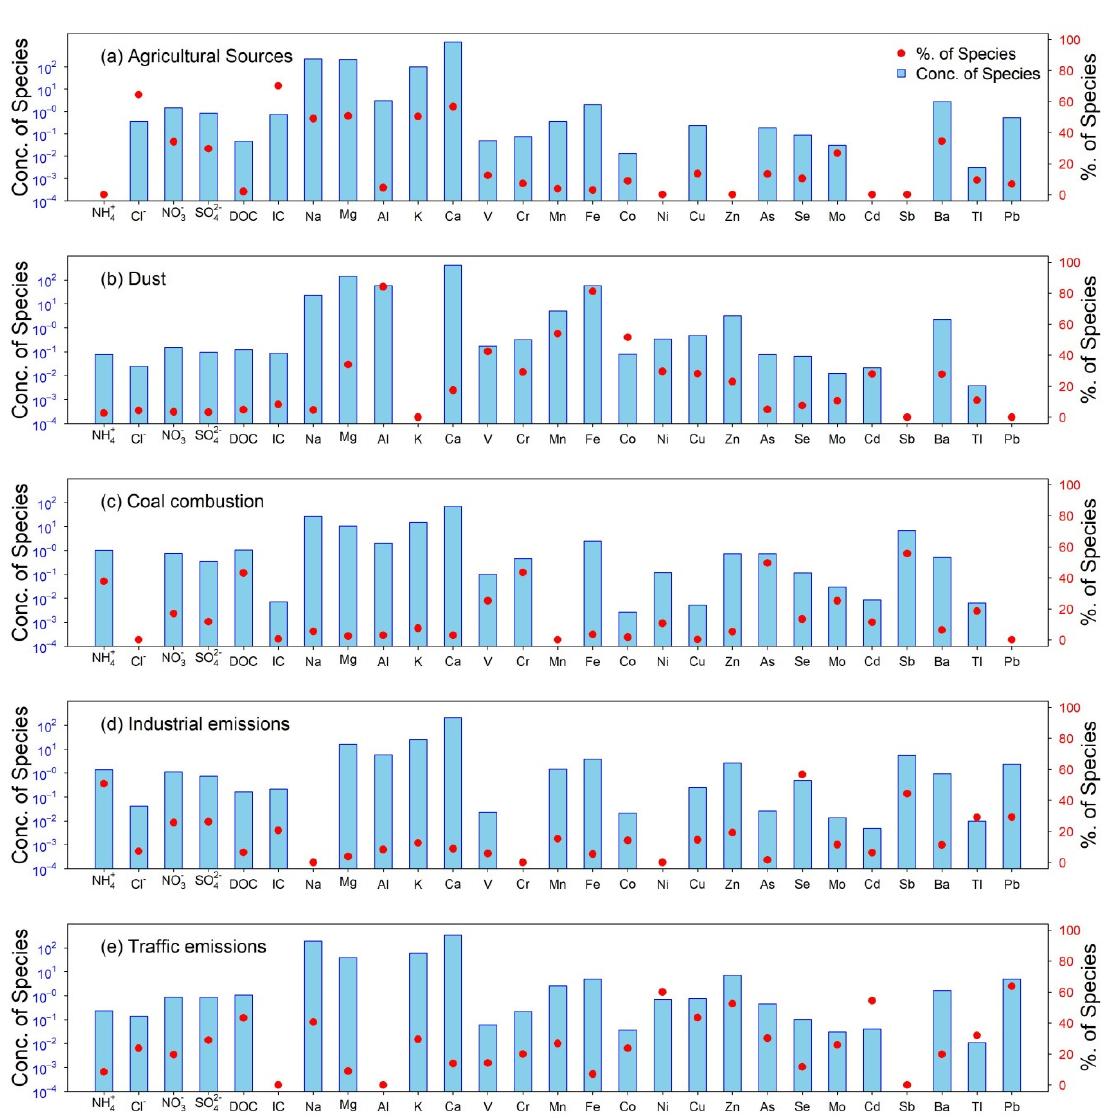
Figure 7. Source profiles resolved from atmospheric depositions at the observation site. Five sources were identified as agricultural sources ( a ), dust ( b ), coal combustion ( c ), industrial ( d ) and traffic emissions ( e ).